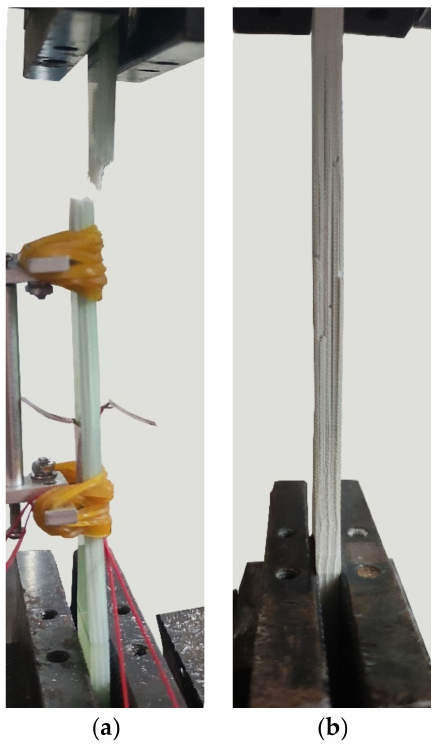
Figure 8. Tensile failure modes: ( a ) fiber fracture, and ( b )